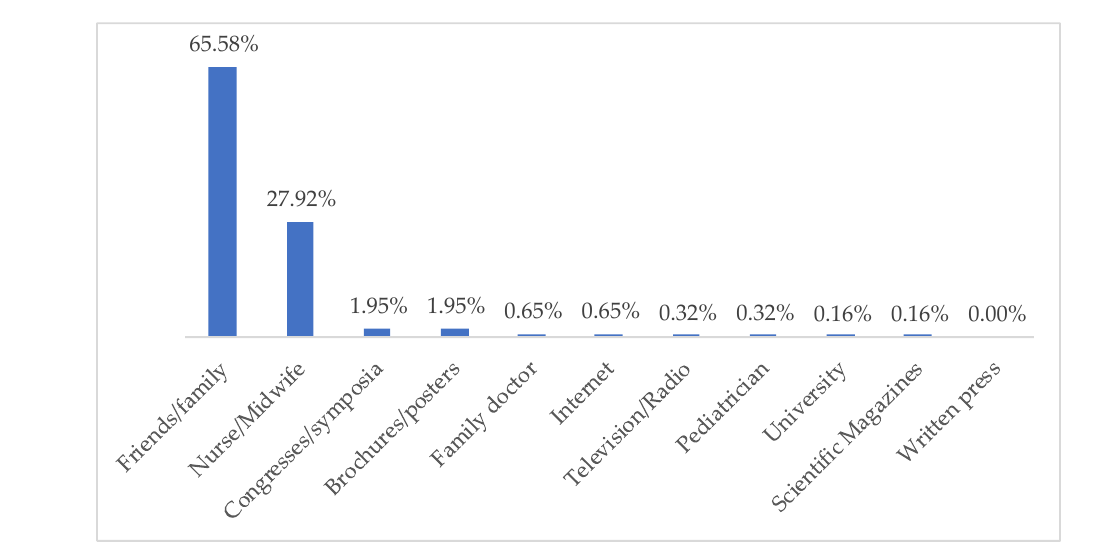
N O Figure 1. Knowledge about the vaccines that are necessary for health professionals. 3.4. Sources of Information